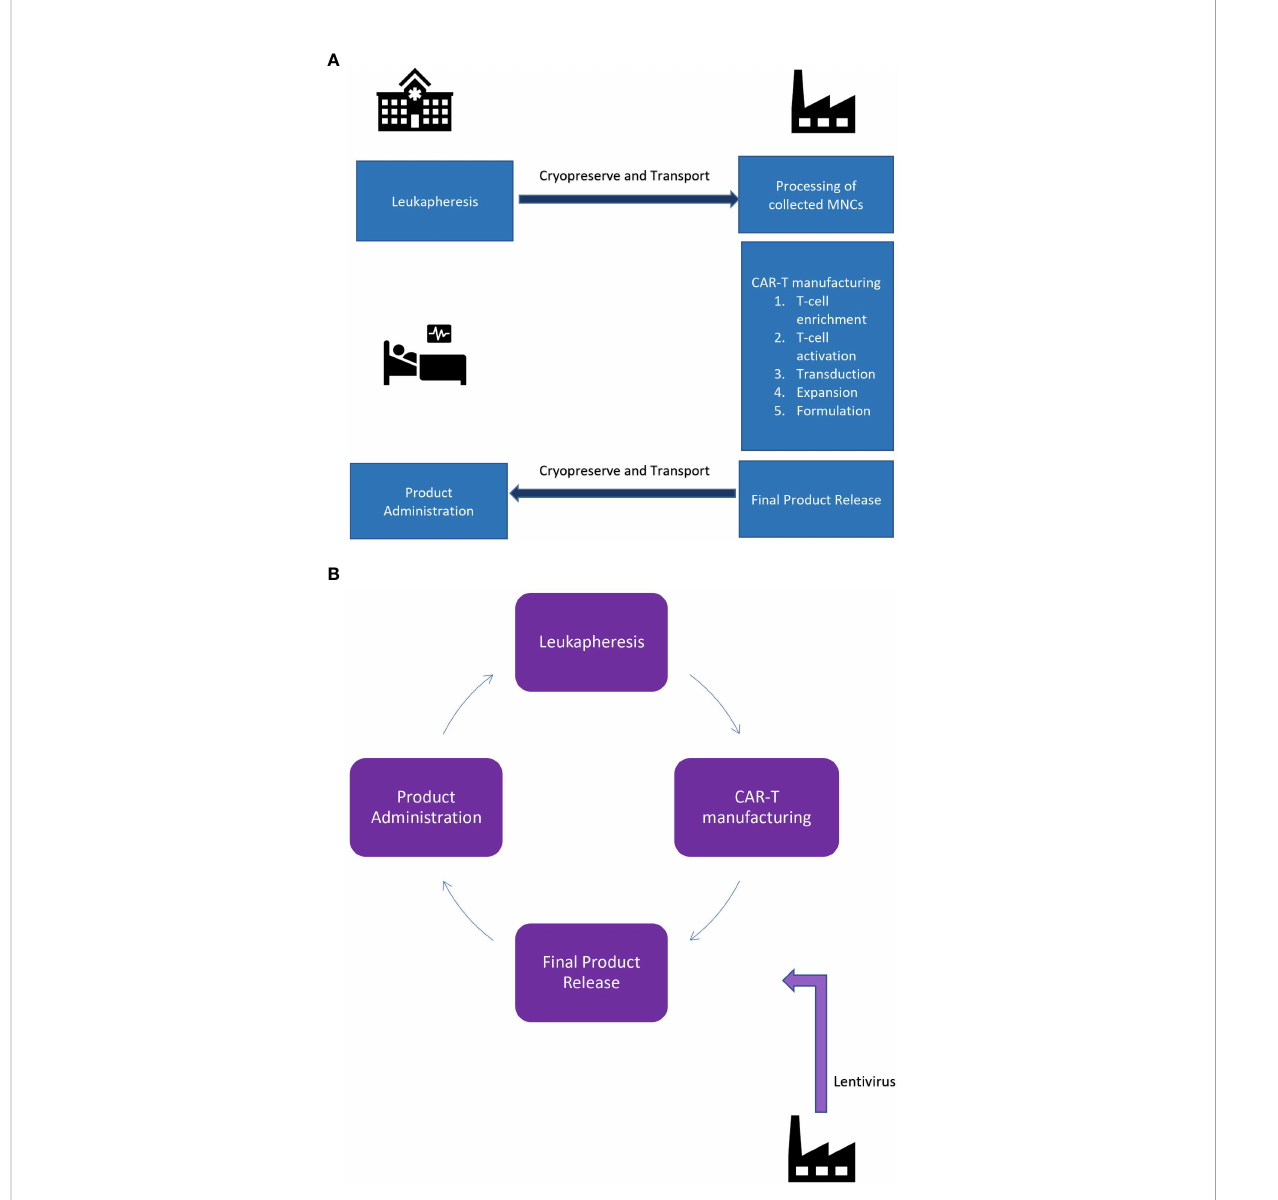
FIGURE 1 (A) Centralized manufacturing facility: Point of care and point of manufacturing is geographically seperated. (B) De-centralized manufacturing facility: Point of care and manufacturing is the